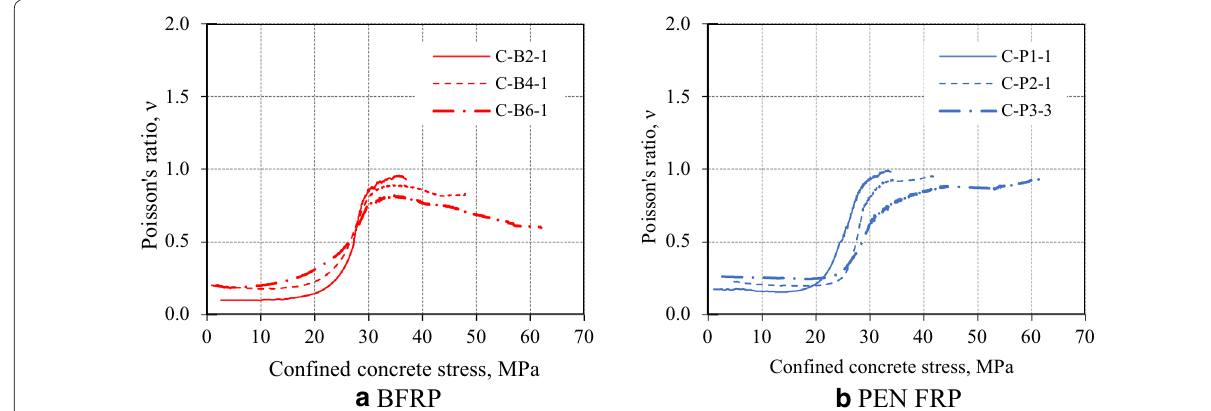
Fig. 10 Relationship of axial stress and Poisson’s Ratio: test results.